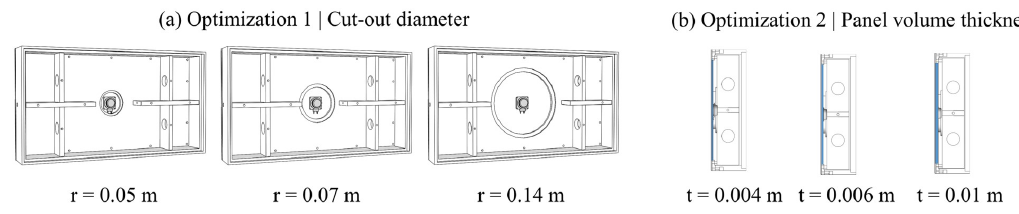
Figure 13. Illustration of the individual optimization parameters: ( a ) changes of the cut-out diameter; and ( b ) changes of the panel volume.